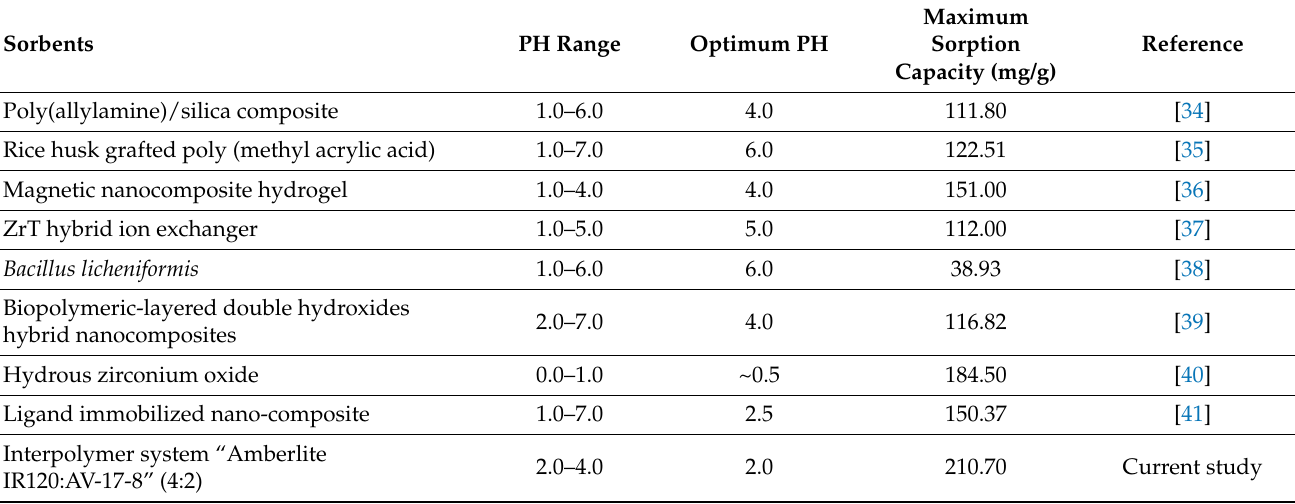
Table 2. The effect of the solution pH on the maximum capacity of various sorbents for cerium ions.